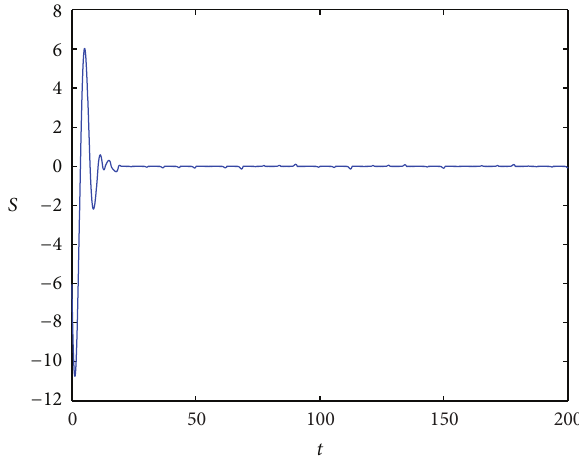
Figure 2: Synchronization performance of fractional-order Duff- ing-Holmes systems (25) and (26).